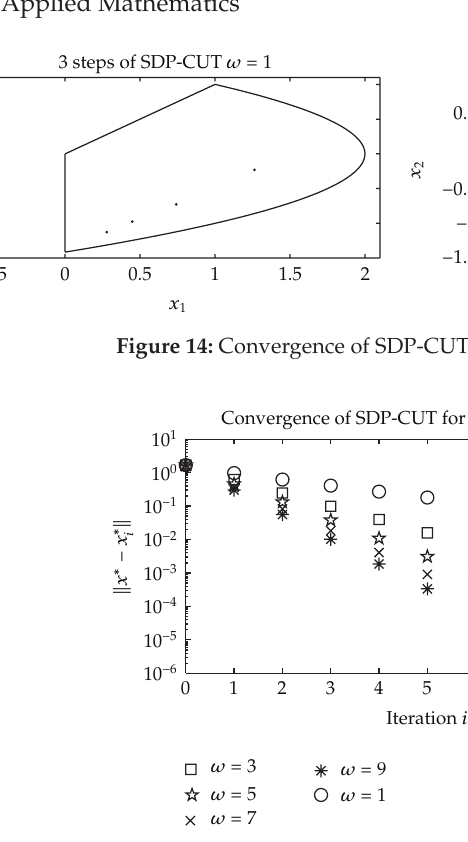
Figure 15: Convergence for various weights w on a log